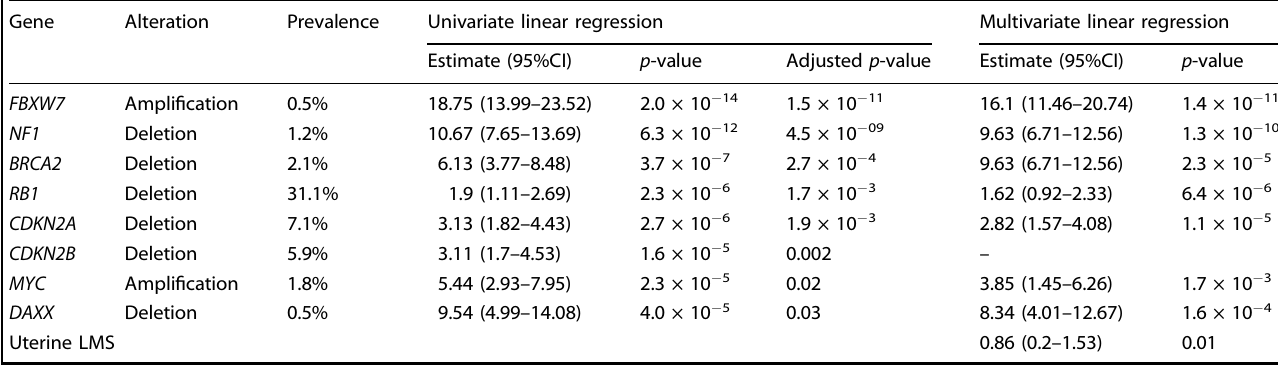
Table 2. Pathway agnostic linear regression of genomic loss of heterozygosity. Gene Alteration Prevalence Univariate linear regression Multivariate linear